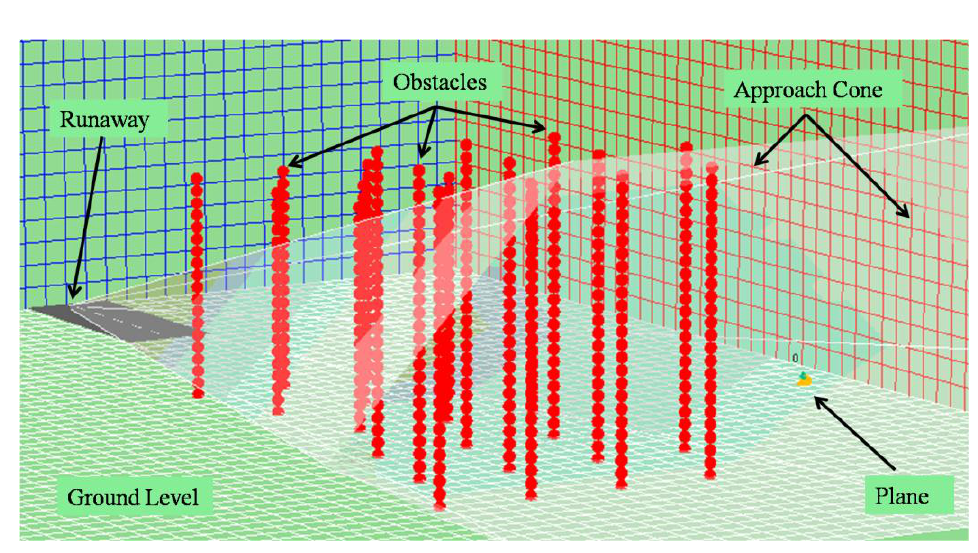
Figure 15. Visualization of the scenario designed in simulation Sim5.